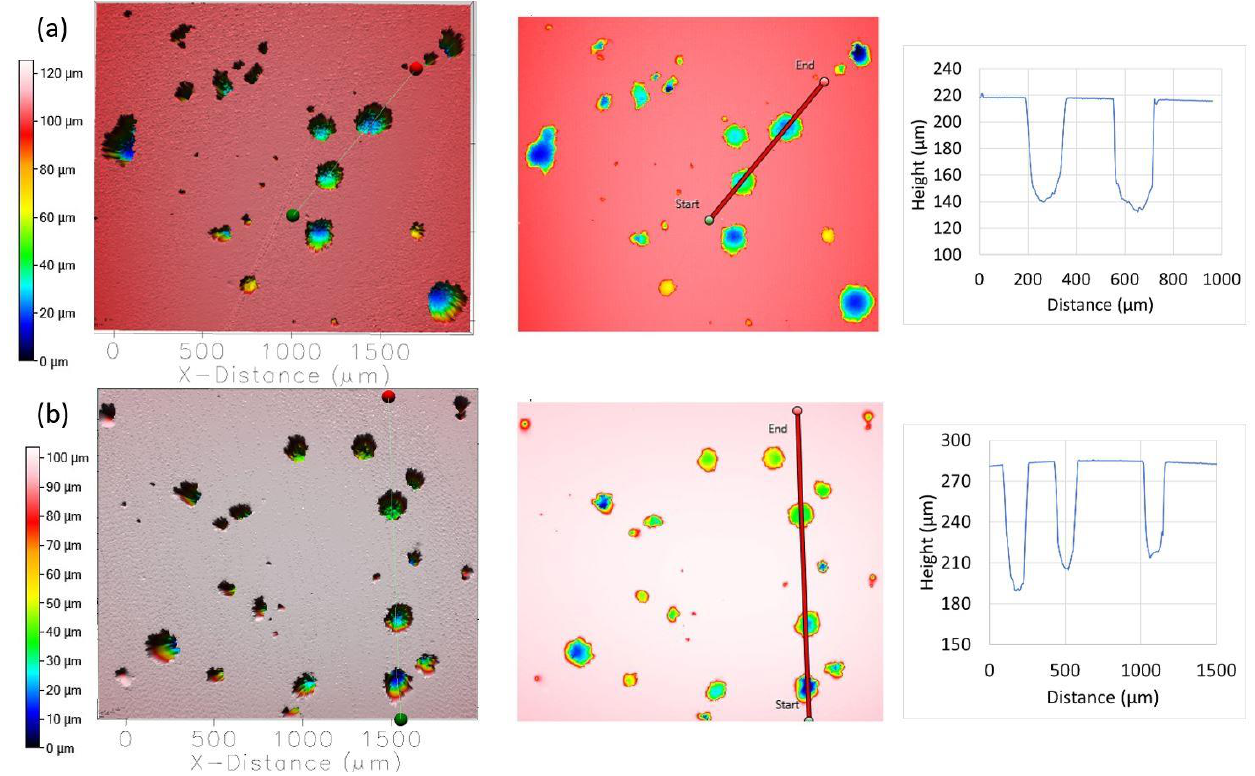
Figure 14. Topographic view of the segment of the corroded AISI 304L surface after potentiodynamic polarization measurement in seawater at 298 K with ( a ) 10 ppm of S 2− and ( b ) 40 ppm of S 2− . The depth and width of pits are determined along the red lines.